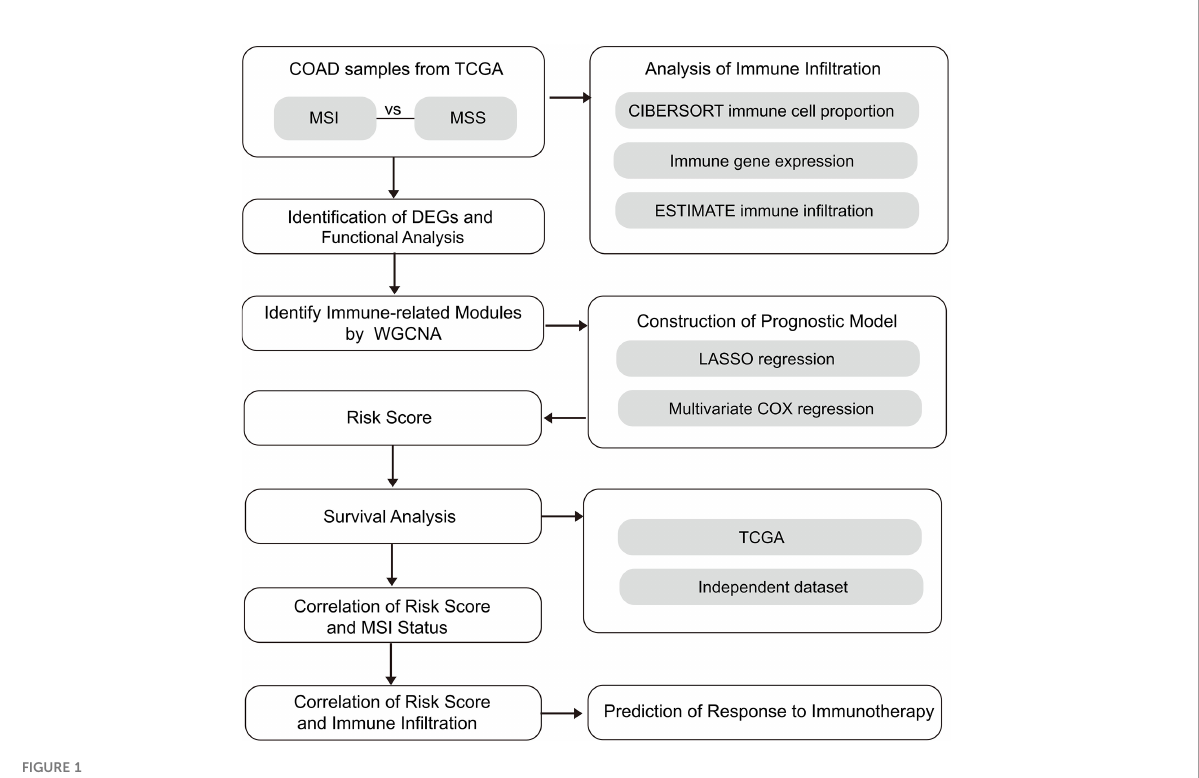
FIGURE 1 The study design schematic